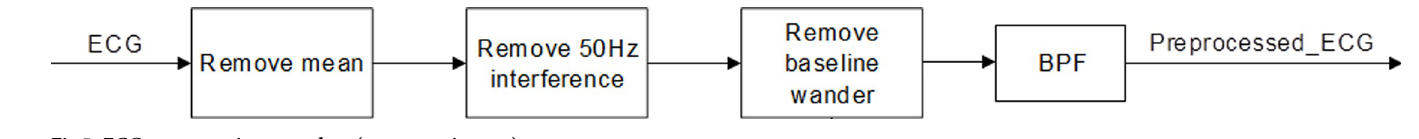
Fig 5. ECG preprocessing procedure